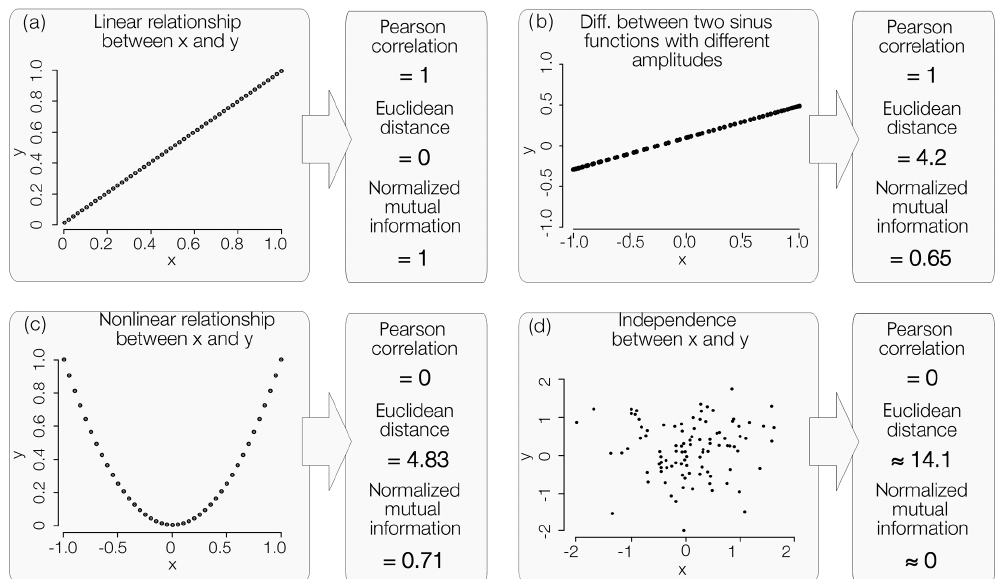
Figure C1. Difference between the Pearson correlation coefficient, Euclidean distance and the normalized mutual information. Four cases are shown: (a) linear relationship, (b) the difference between two sinus functions with different amplitude, (c) a quadratic relationship and (d) two independent variables. The pdf was estimated using an equidistant bin width of 0.05 in all four